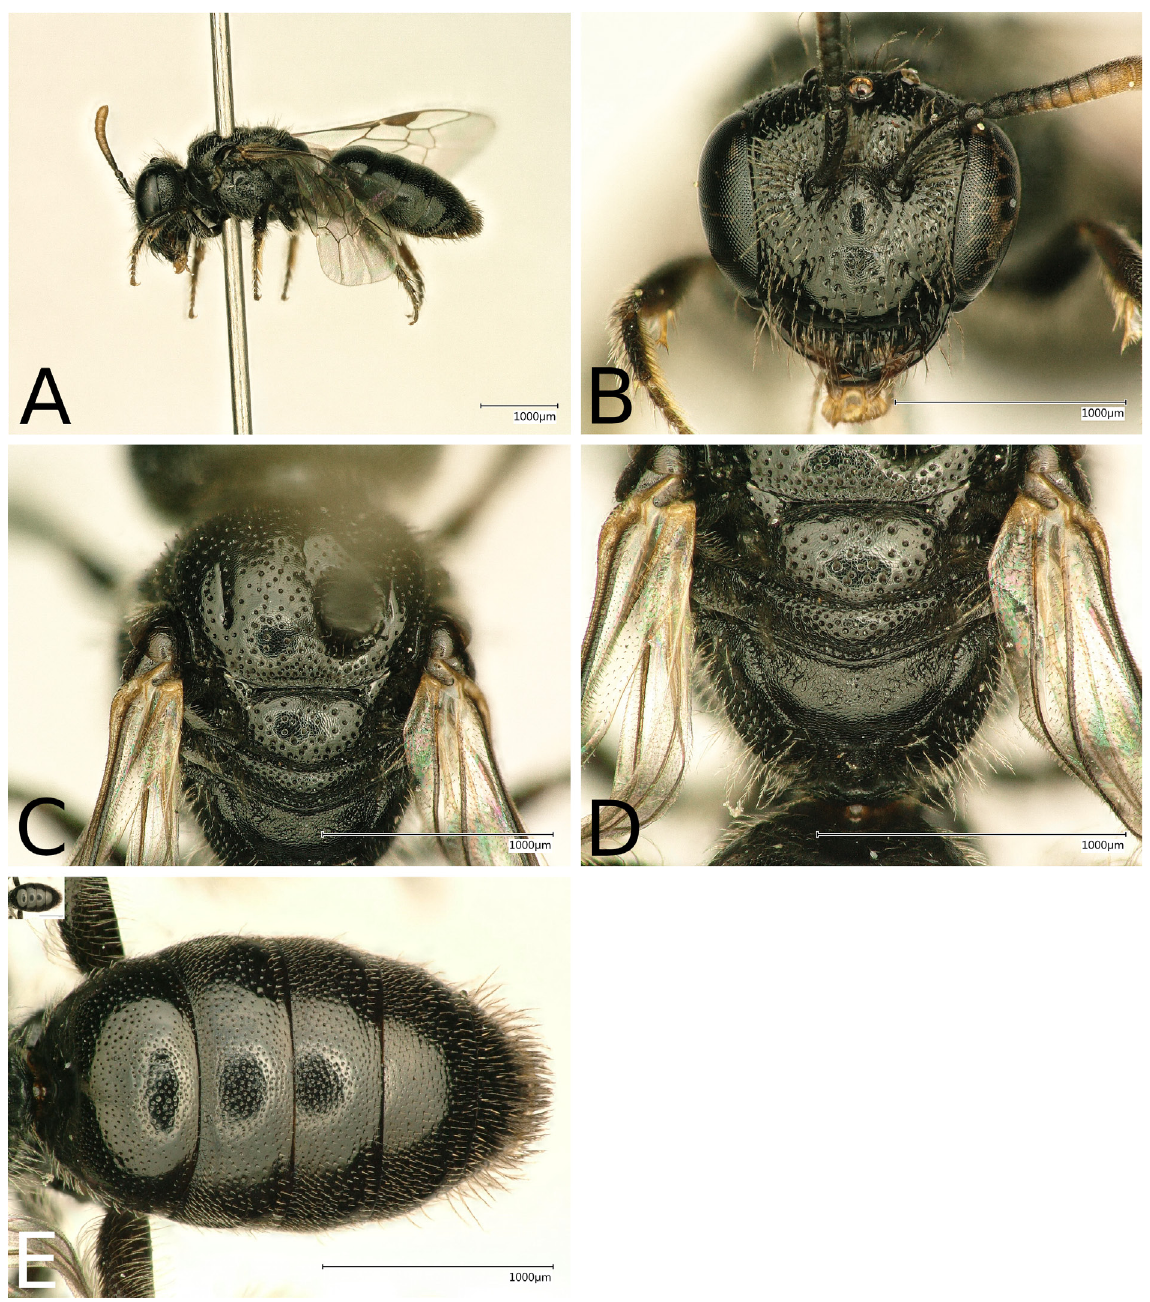
Fig. 2. Scrapter bokkeveldensis Kuhlmann sp. nov., ♀, holotype (RCMK). A . Lateral view. B . Head. C . Scutum and scutellum (dorsal view). D . Metanotum and propodeum (dorsal view). E . Metasoma (dorsal